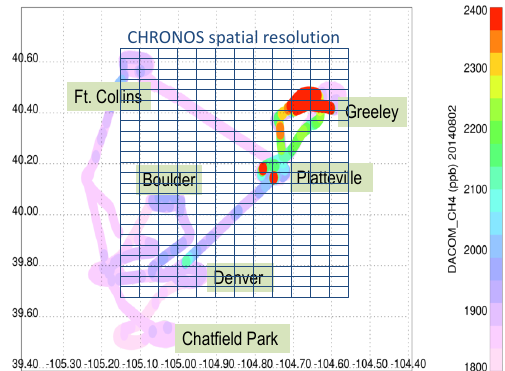
Figure 3. Aircraft in situ measurements of CH 4 from the FRAPPE- DISCOVER-AQ in the Colorado Front Range on 2 August 2014. Vertical profiles were measured over cities, identified by spiral flight tracks (each spiral has ∼ 10km radius), where the highest values of CH 4 are plotted last. Total column CH 4 computed from the vertical profiles is different by 4.9% between Greeley (oil/gas and feedlot operations) and Ft. Collins (urban). CHRONOS pixel spatial reso- lution is indicated by the overlaid grid, illustrating that CHRONOS column measurements would have the spatial resolution and pre- cision to distinguish sub-hourly differences in county-scale CH 4 abundances. Note that the grid in this figure only indicates pixel resolution and not the observational domain; CHRONOS images the entire North American field of view in each 60ms frame. DA- COM (differential absorption carbon monoxide monitor) CH 4 data are courtesy of Glenn Diskin,